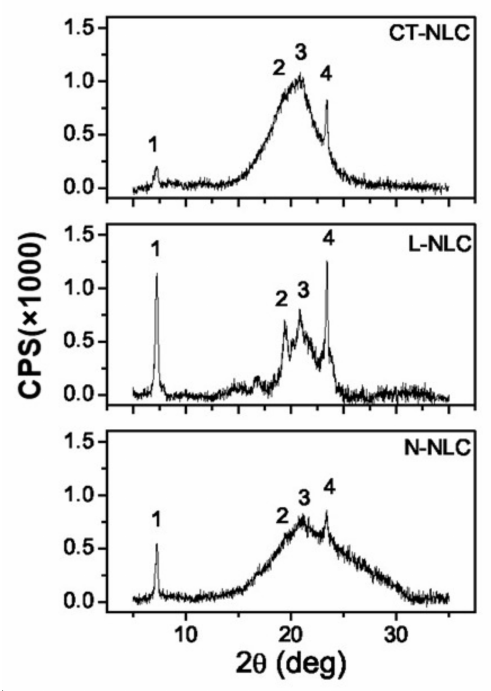
Figure 5. XRD spectra of representative samples L-NLC, CT-NLC, and